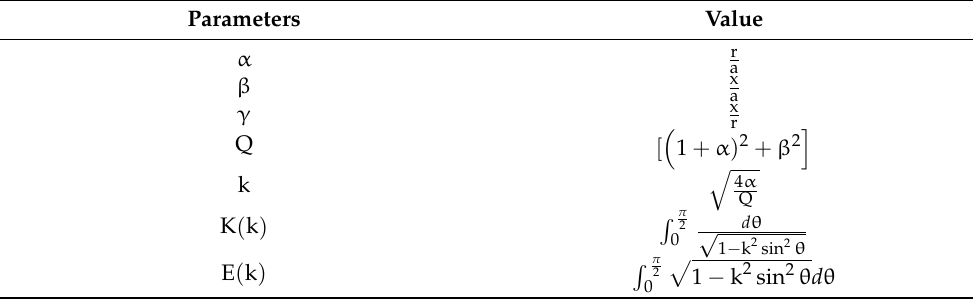
Table A1. Characters required for calculating the magnetic field of a circular coil.